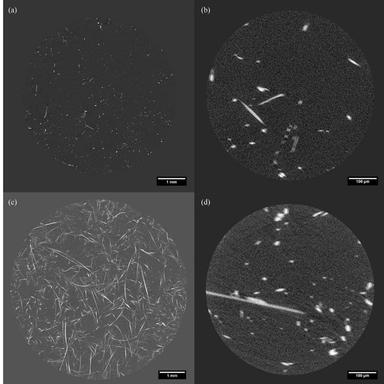
2D reconstructed slices of sample 406 at 3.5 μm/voxel (a) and at 1.0 μm/voxel (b) and sample 409 at 3.5 μm/voxel (c) at 1 μm/voxel (d).